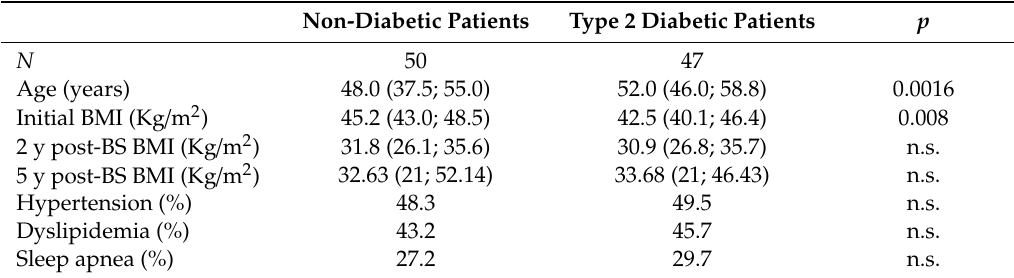
Table 1. Baseline characteristics of the patients included in the study.